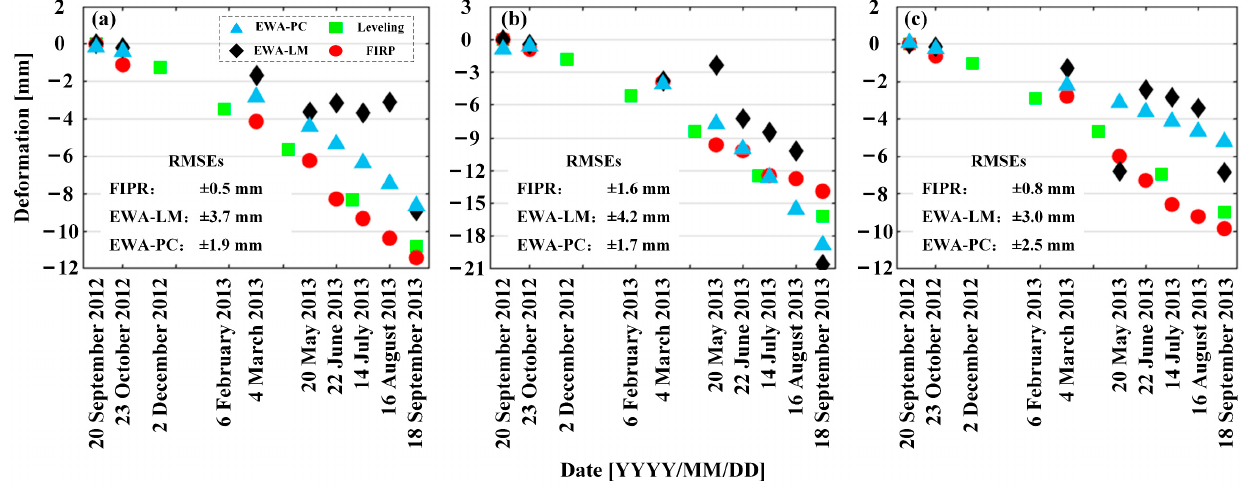
Figure 11. RMS of HP deformation comparison of 23 SAR images (EWA-LM: linear model with equal weight accumulation; EWA-PC: Poisson curve with equal weight accumulation).